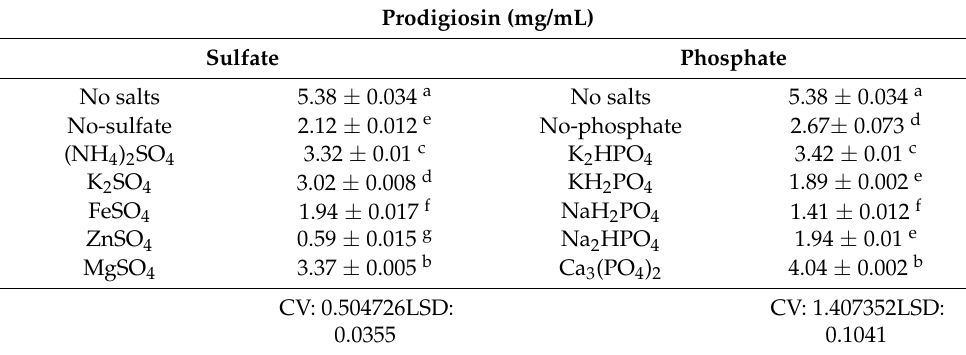
Table 2. Effect of salt addition on prodigiosin